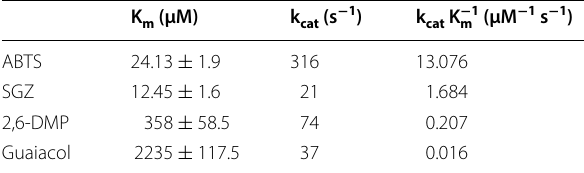
Table 2 K and k values of Mrl2 with ABTS, SGZ, m cat